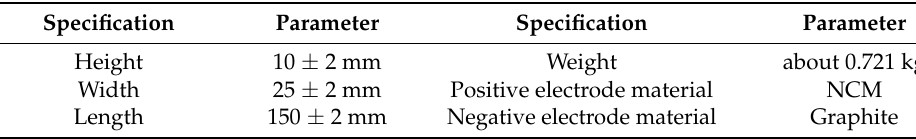
Figure 6. Relevant experimental equipment [29]. Table 3. Battery specification.